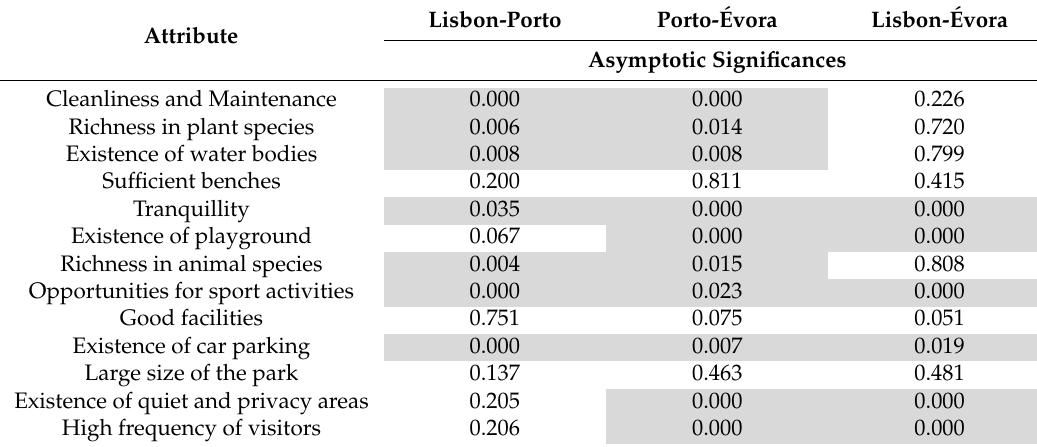
Table 4. Analysis of Kruskal-Wallis test for the mean of the rescaled scores among the three cities. The grey shade indicates significant differences between the mean scores among urban areas for a significance level =